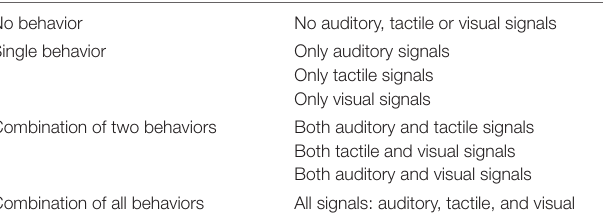
TABLE 2 | Combinations between maternal sensory